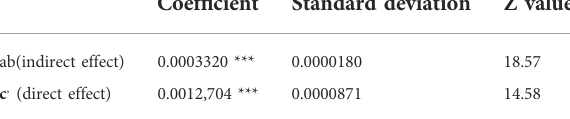
TABLE 7 Intermediation effects Bootstrap test results.